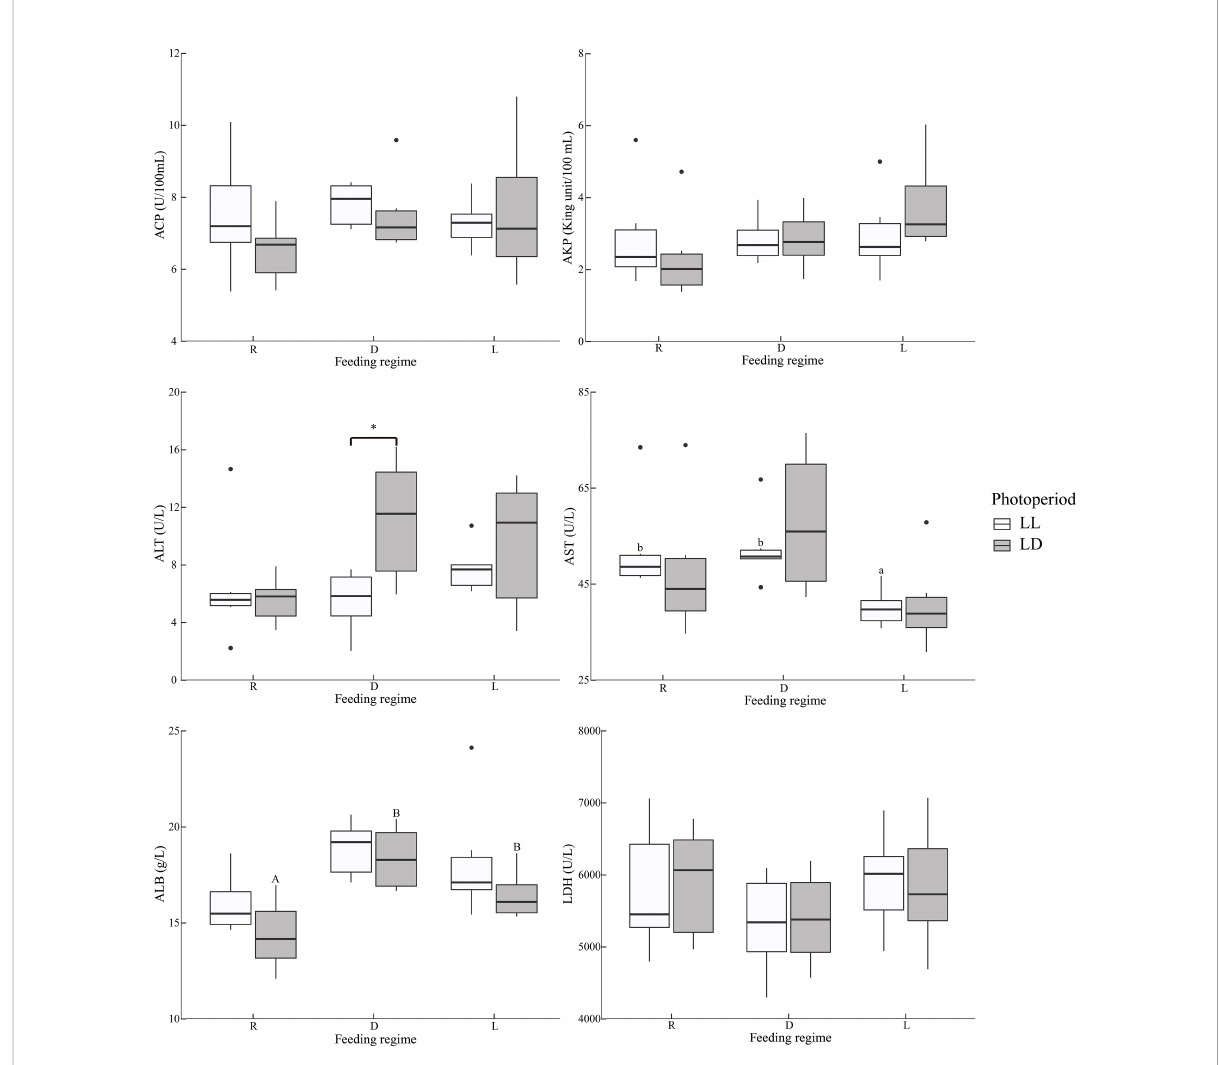
FIGURE 1 Liver health indicators of juvenile Oncorhynchus mykiss under different experimental treatments (n=6). ACP, Acid phosphatase; AKP, Alkaline phosphatase; ALT, Alanine aminotransferase; AST, Aspartate aminotransferase; ALB, Albumin; LDH, Lactate dehydrogenase; R, random feeding; D, mid-dark stage feeding; L, mid-light stage feeding; LL: 24L: 0D, LD: 12L: 12D. Different lowercase letters and capital letters indicate signi fi cant difference among different feeding regimes at the LL (24L: 0D) and LD (12L: 12D, lights-on at 6:00), respectively ( P < 0.05). Asterisks denote signi fi cant differences between photoperiods at the same feeding regime (* P < 0.05). Points outside the box plot are